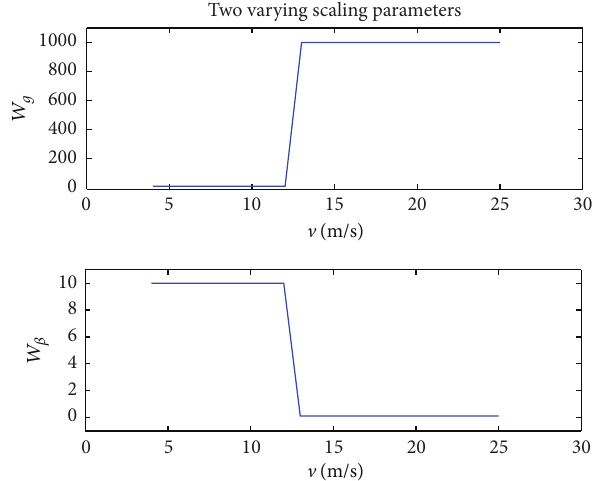
Figure 5: Prescribed functions for varying scaling parameters of weighting functions.